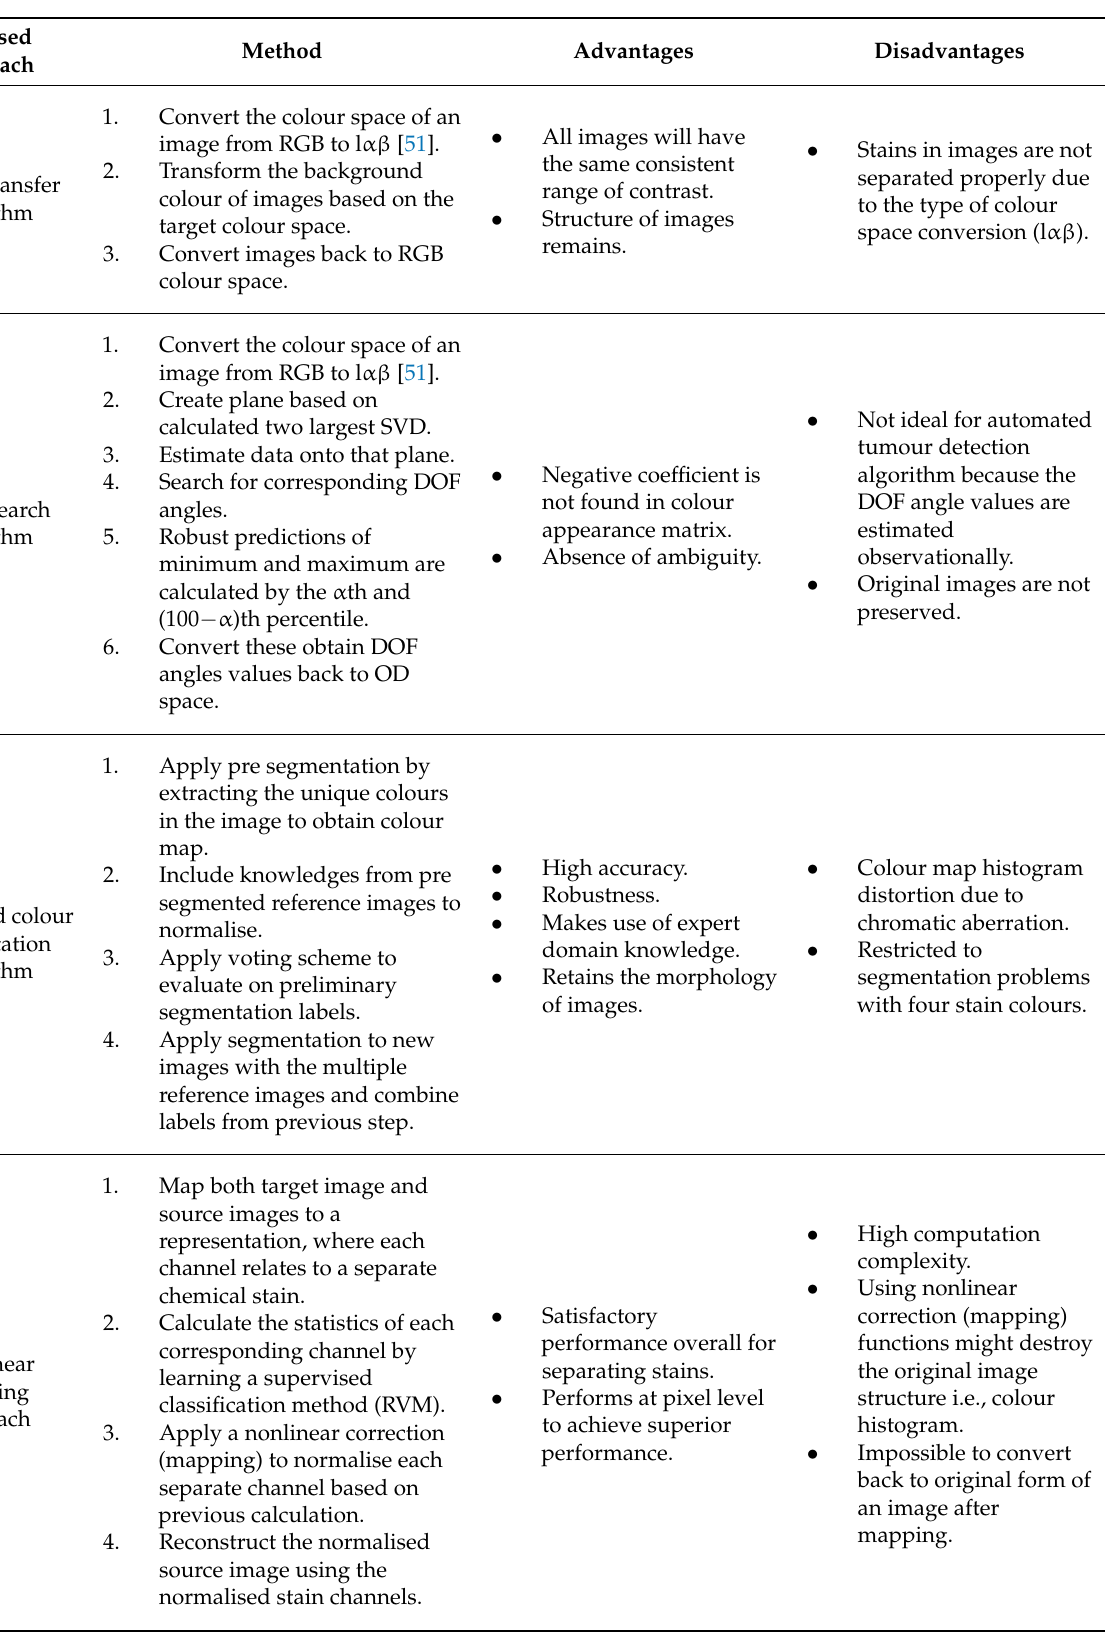
Table 1. Comparison of colour normalisation